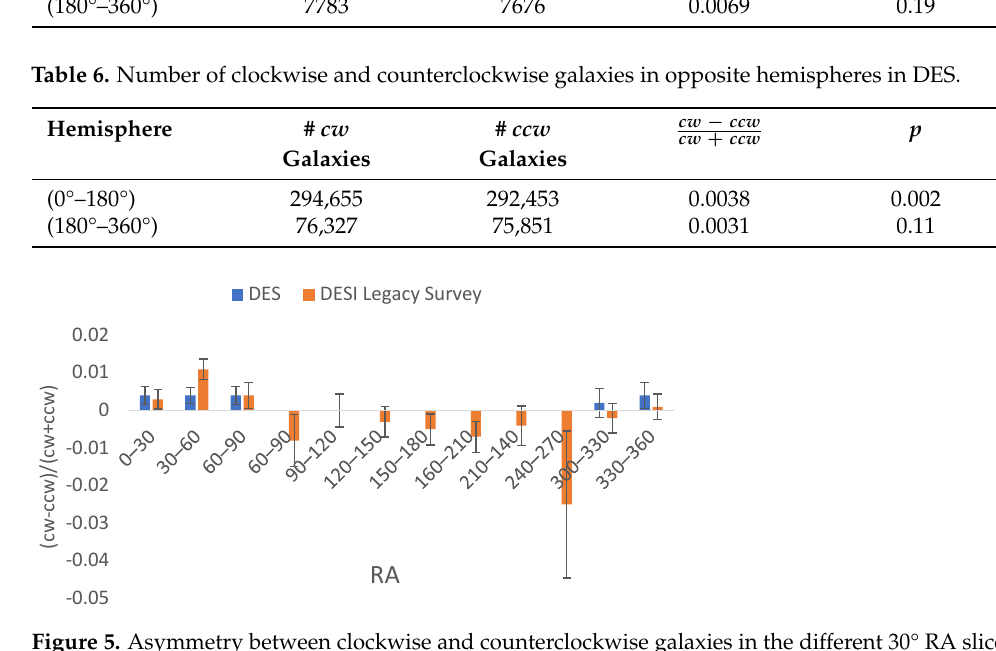
Figure 5. Asymmetry between clockwise and counterclockwise galaxies in the different 30° RA slices in DES and DESI Legacy Survey. DES does not provide data in the RA range of between 60° and